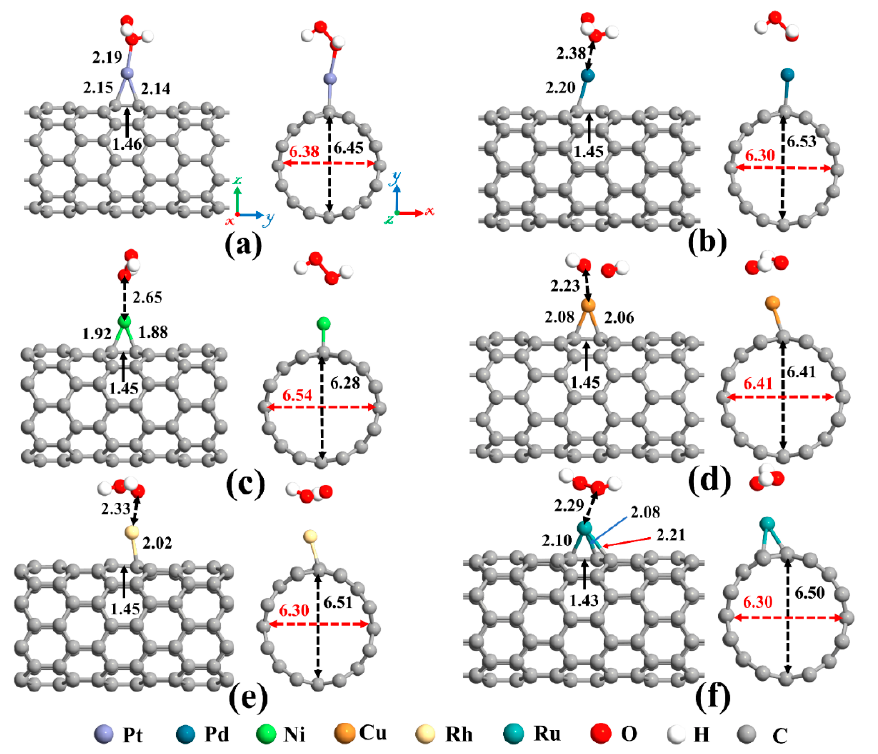
Figure 7. Optimized structures of H 2 O 2 on ( a ) Pt-SWCNT, ( b ) Pd-SWCNT, ( c ) Ni-SWCNT, ( d ) Cu-SWCNT, ( e ) Rh-SWCNT, and ( f ) Ru-SWCNT systems. The bond lengths, the diameters, and the binding distances between the metal atom and the nanotube are also given in the unit of Å. The sticks between atoms are only for visualization. The red and black dotted arrows present the diameter of the nanotube parallel and perpendicular orientation to the axis of the nanotube, respectively.